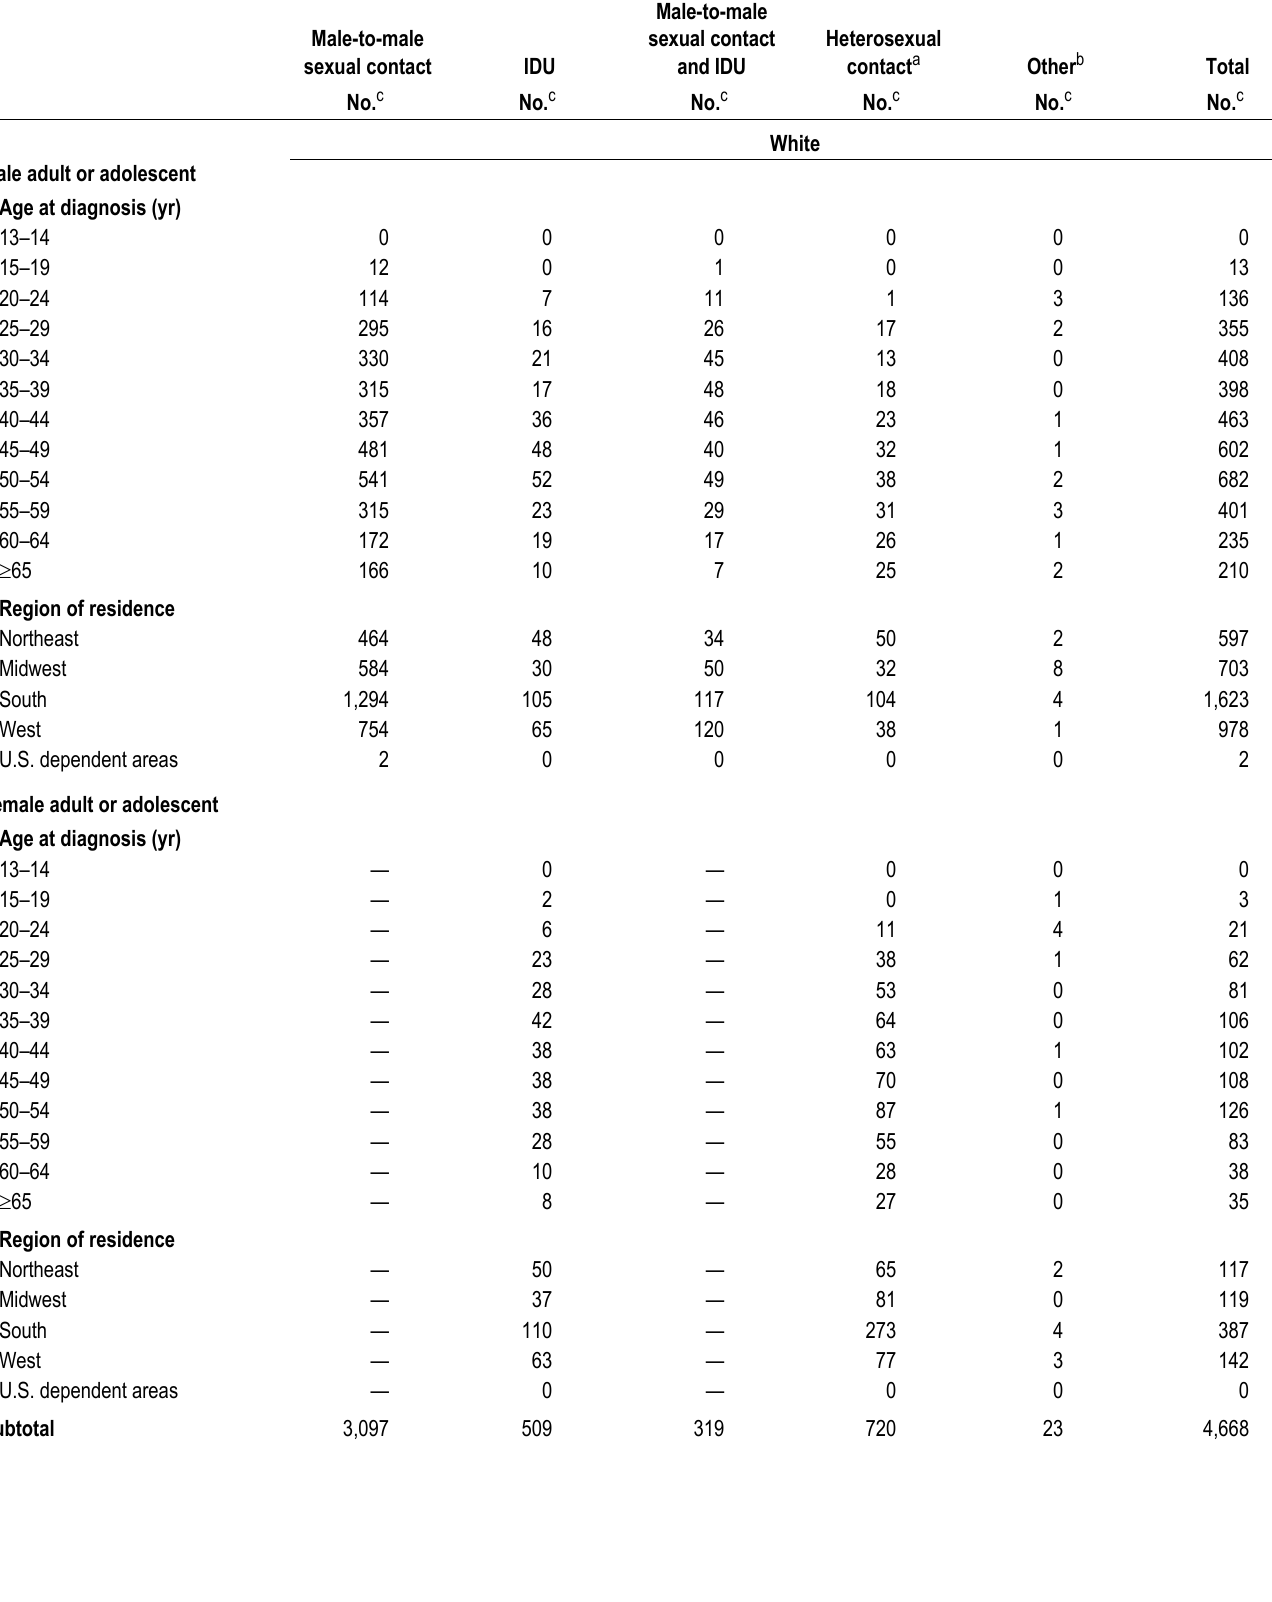
Table 6b. Stage 3 (AIDS), by transmission category, race/ethnicity, and selected characteristics, 2015—United States and 6 dependent areas